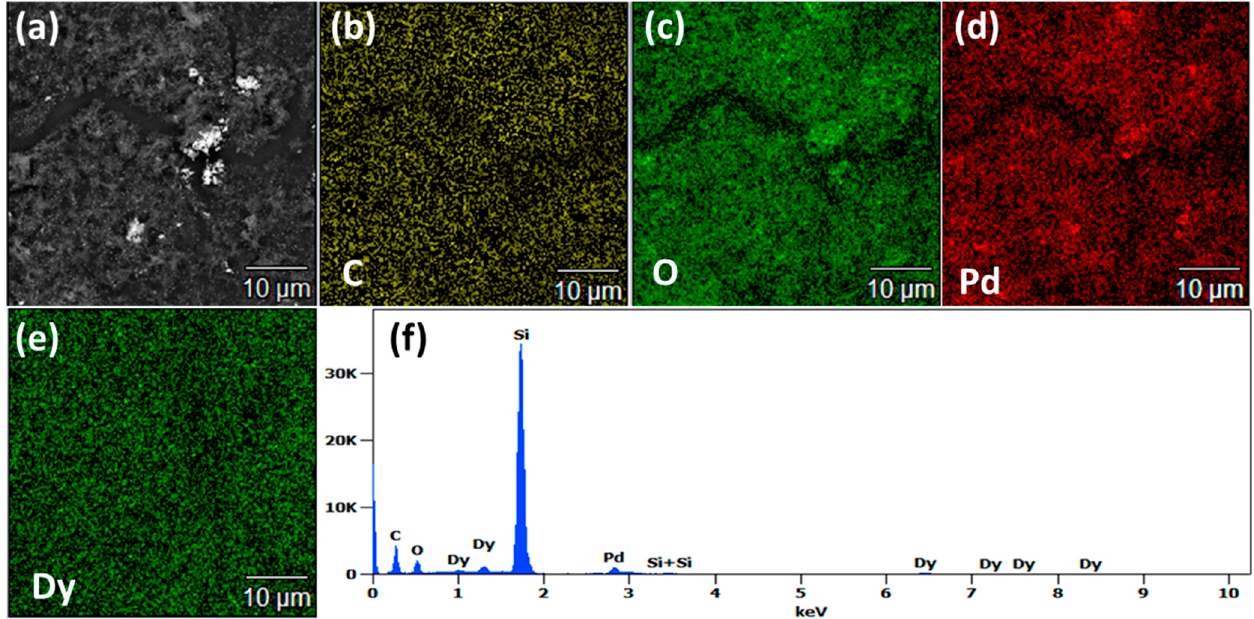
Figure 5. EDS image ( a ) and mapping of ( b ) carbon, ( c ) oxygen, ( d ) palladium, and ( e ) dysprosium; and ( f ) elemental measurement of the Dy 2 O 3 -Pd-PDA/rGO nanocomposite.